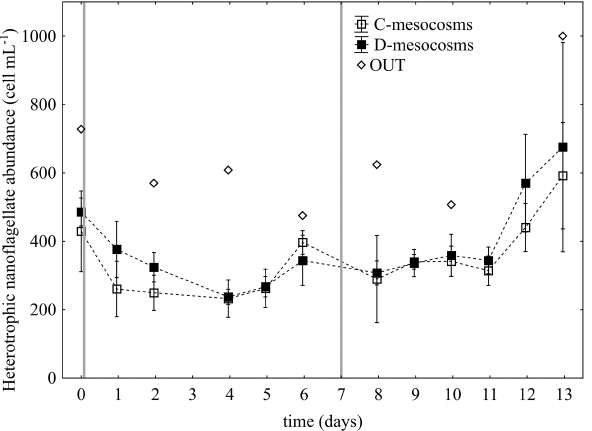
Figure 8. Heterotrophic nanoflagellate abundance (cellmL − 1 , mean ± standard deviation of three replicate mesocosms) in DUST- and CONTROL-mesocosms and OUT samples at 5m depth dur- ing the DUNE-R experiment. Grey vertical bars represent the dust